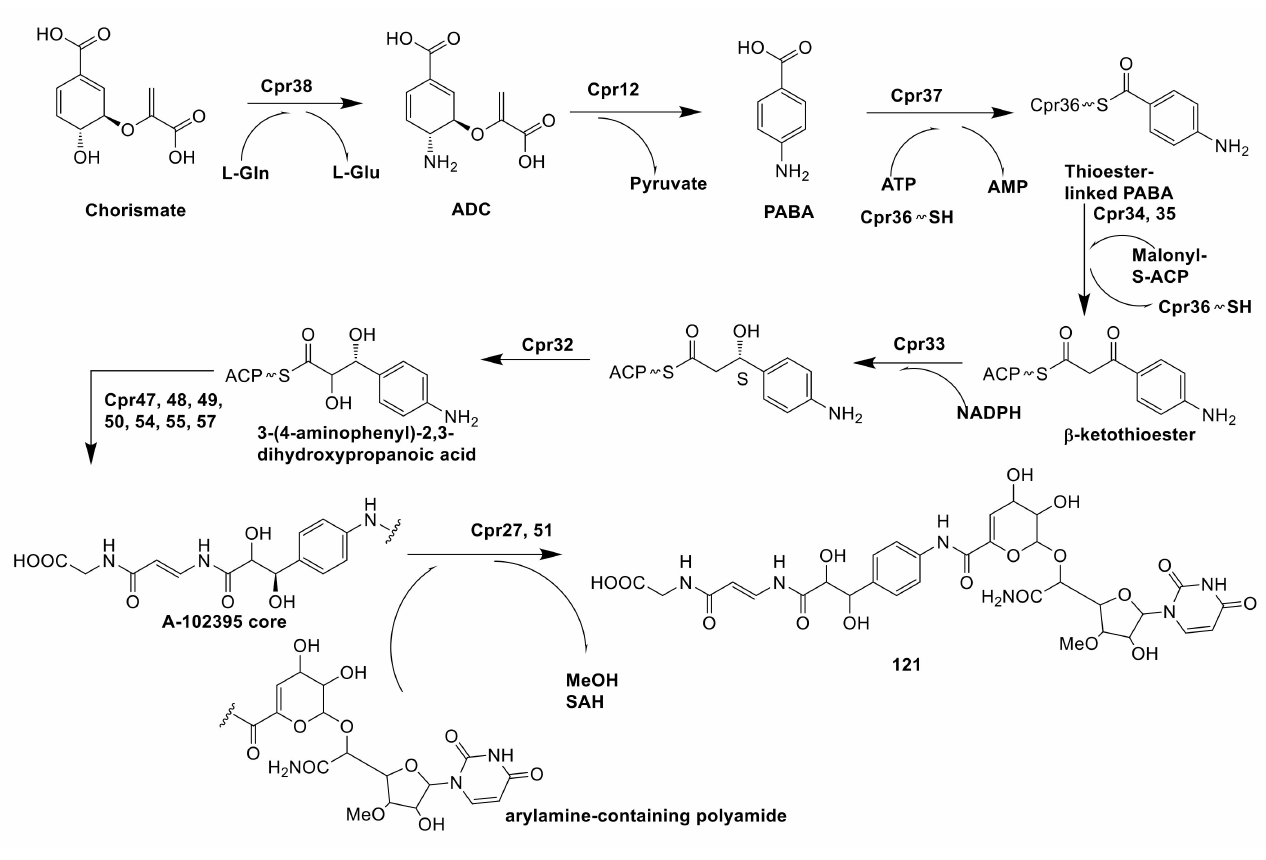
Figure 11. The biosynthetic pathway of A-102395